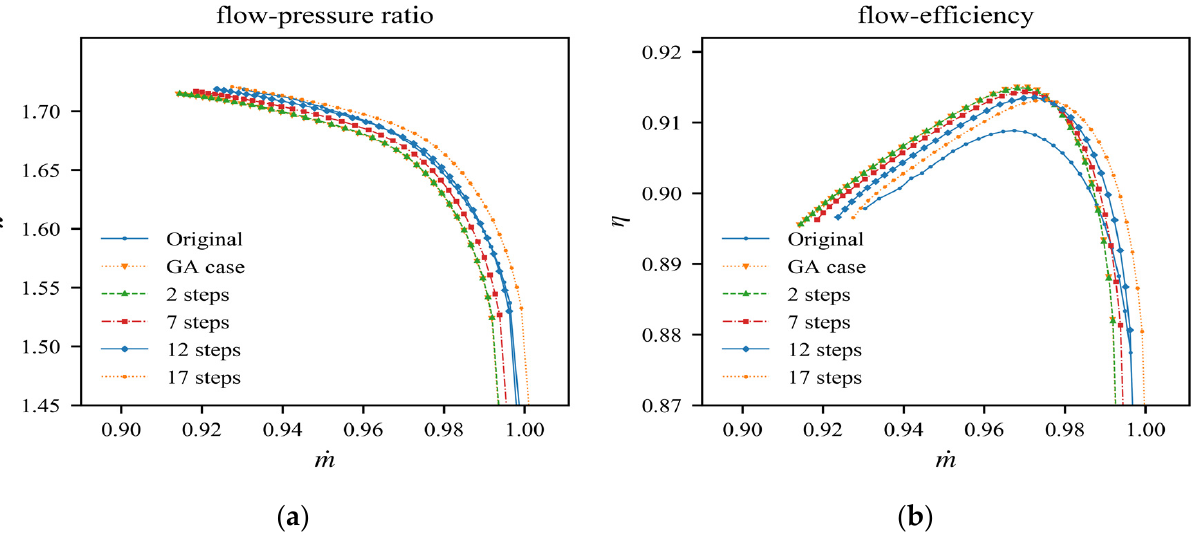
Figure 13. Operation characteristics of the modified rotors. ( a ) Flow-pressure ratio. ( b ) Flow efficiency. The variations in the near-peak efficiency performance metrics π W and η W were plotted in Figure 14. The performance of different rotors at the same mass flow rate